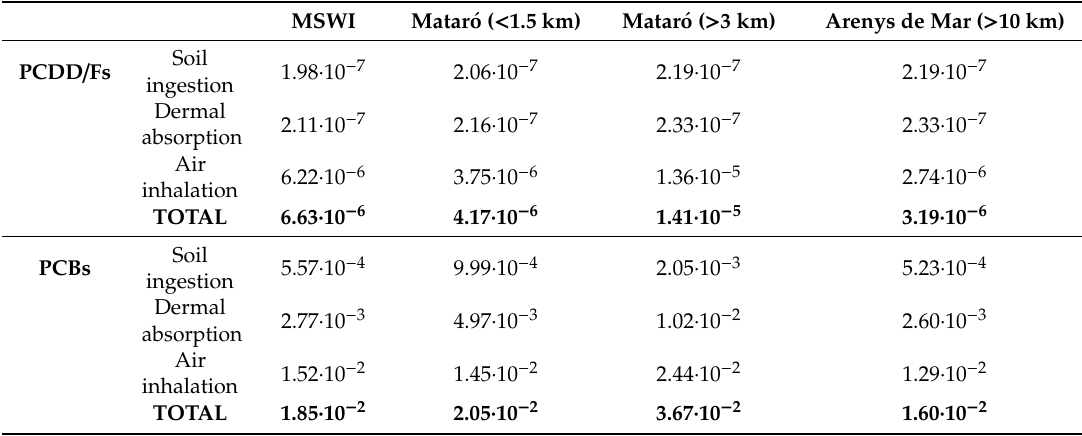
Table 1. Environmental exposure to PCDD/Fs (ng WHO-TEQ/kg·day) and PCBs (ng/kg·day) by the adult population living in different locations around the MSWI of Mataró.